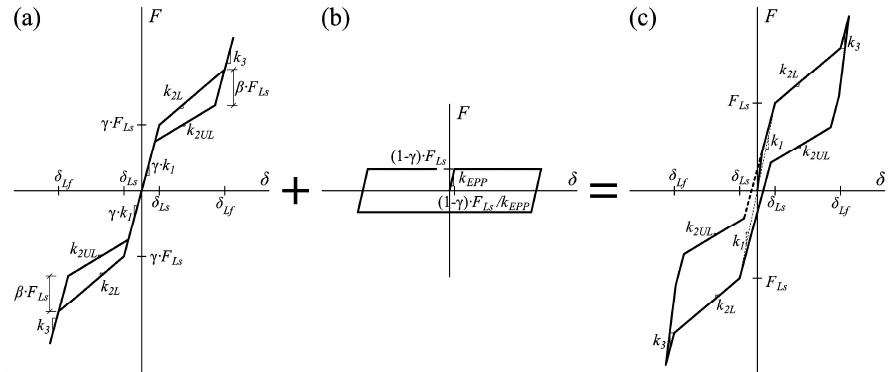
Figure 15. Proposed hysteretic model: ( a ) flag-shape component, ( b ) elastic-perfectly plastic component, ( c ) complete model.